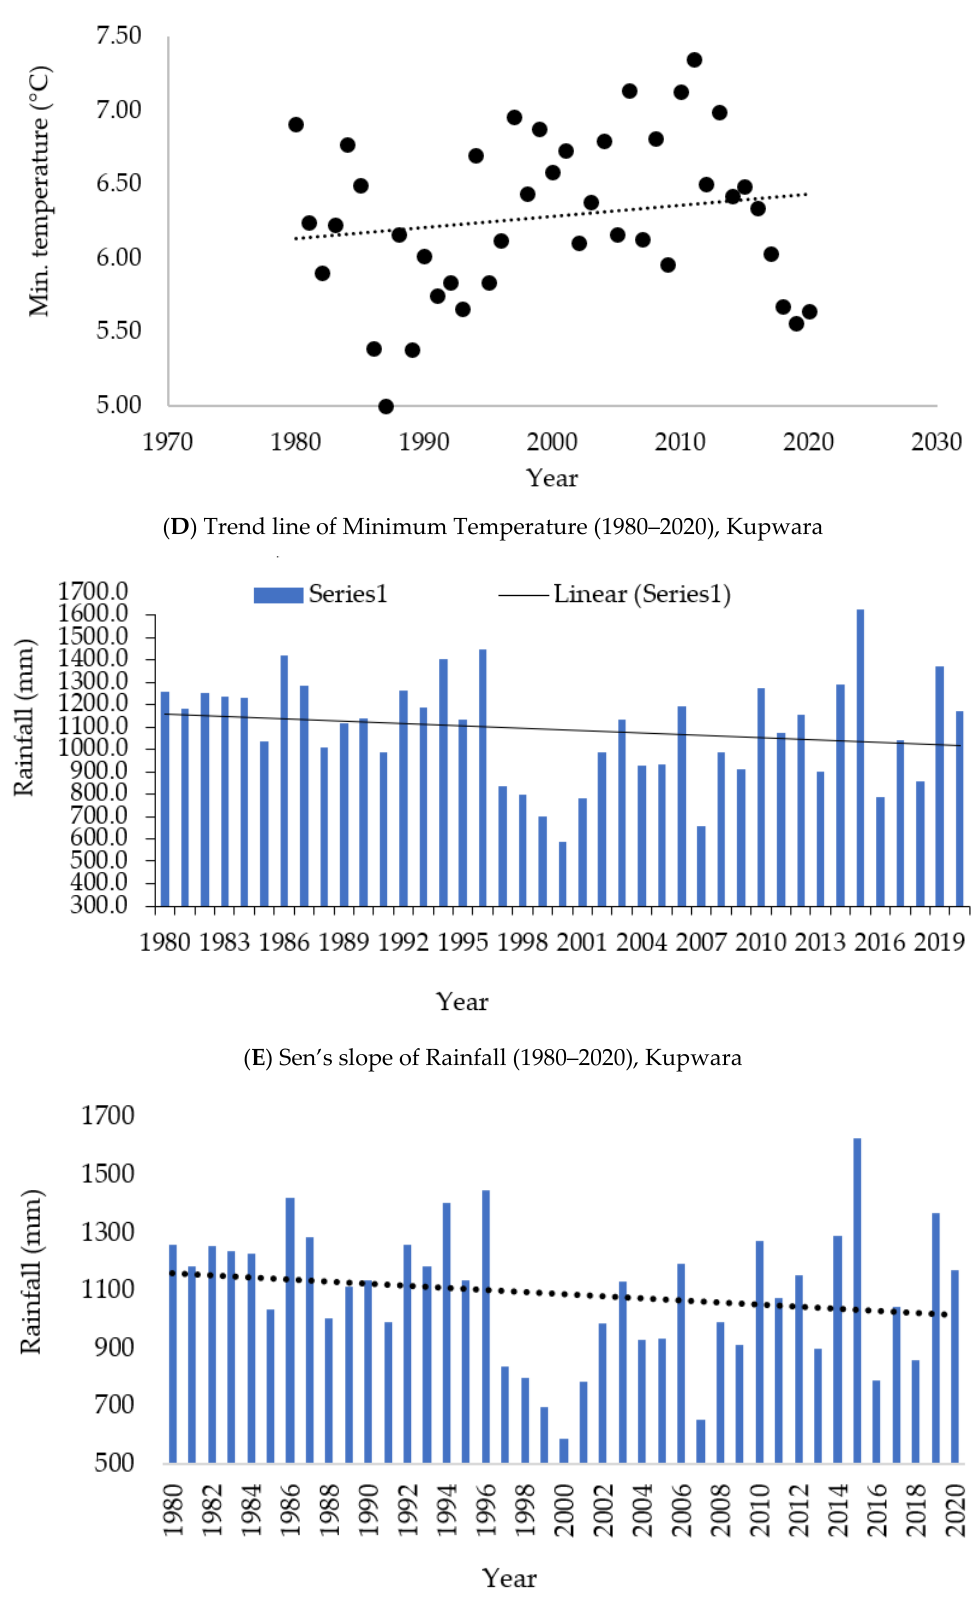
Figure 6. Descriptive statistics of weather parameters viz., Maximum and Minimum temperature and rainfall of location Kupwara